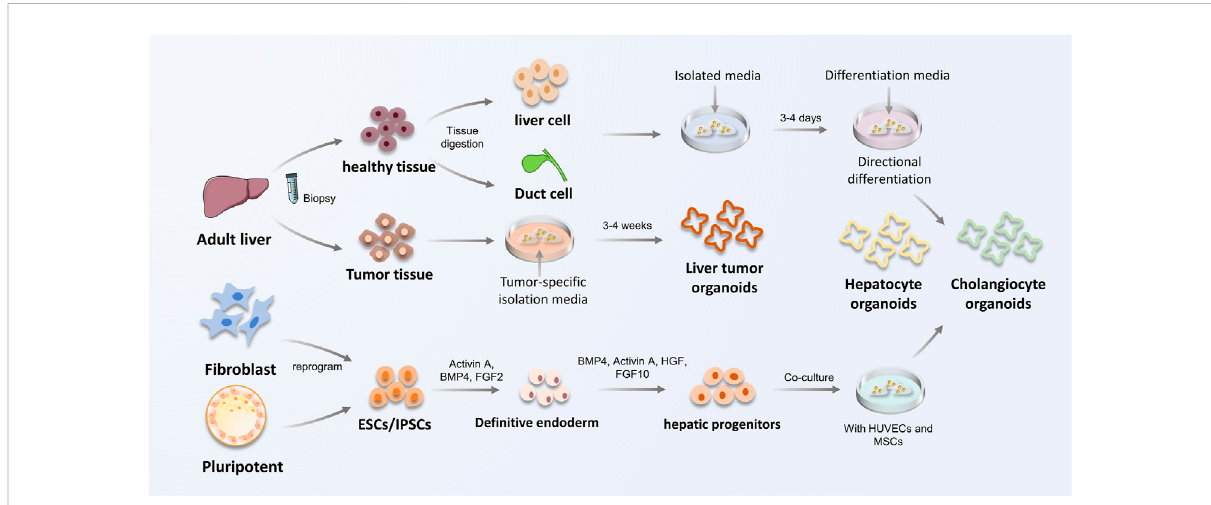
FIGURE 2 The construction procedure of ASC and PSC-derived liver organoids. The process of constructing liver organoids is divided into ASC and PSC origin.ASCaremainlyderivedfrombiopsyofadulttissuestoobtainhealthyortumortissues.Hepatocytesorbileducttissuesobtainedfrombiopsies were inoculated in isolation medium, and subsequently hepatocyte organoids and cholangiocyte organoids were constructed using de fi ned differentiation media. PSCs can be obtained by reprogramming fi broblasts in vivo , in addition to inner cell mass, which are capable to form hepatic progenitor cells by co-culture and special signal-mediated differentiation towards endoderm, and eventually obtain hepatocyte organoids and cholangiocyte organoids. HUVECs, vein endothelial cells; MSCs, mesenchymal stem